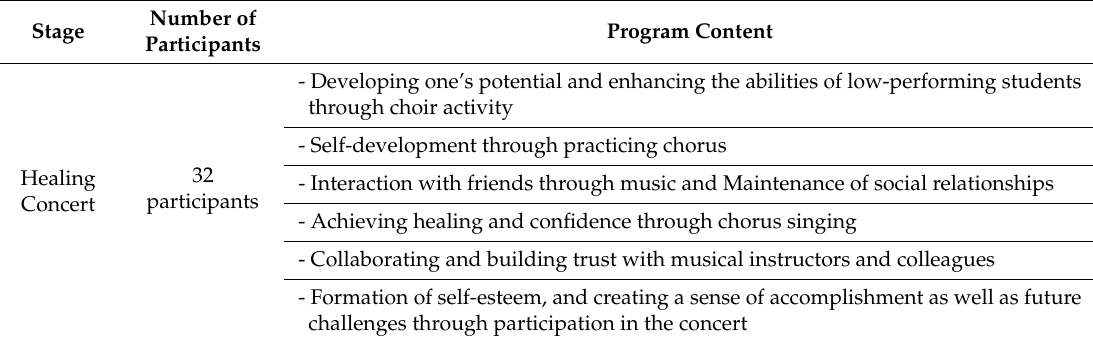
Table 4. Details of the Healing Concert.